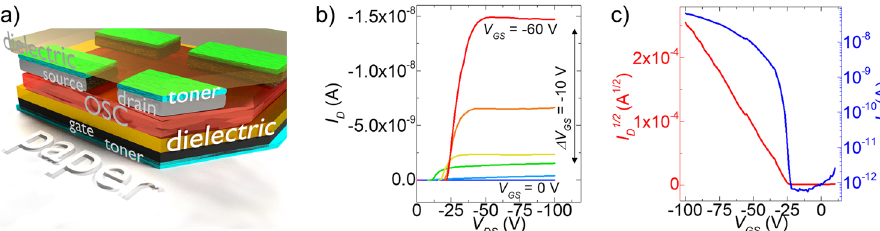
Fig. 6 I – V characteristics for a C8-BTBT semiconductor, Etnom dielectric silver spray device. a Schematic of bottom-gate, top-contact device on paper. Here, OSC is C8-BTBT, dielectric is Etnom, and the source, drain, and gate are silver. b Transport curves. The lines are colored by the voltage applied at the gate as the source – drain voltage is modulated. c Transfer curve for this device. The left y axis shows the square root of the drain current, the right axis shows the drain current plotted on a logarithmic scale in blue with a V DS of − 100 V